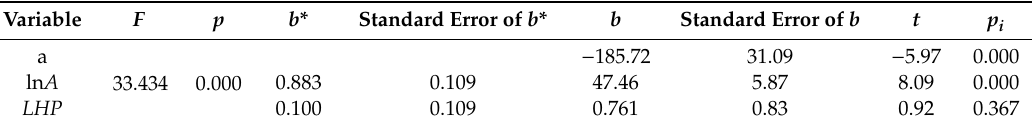
Table 3. Results of the significance analysis of linear regression model and the significance of the component coe ffi cients of regression for the model for estimating Q MED throughout the Upper Vistula